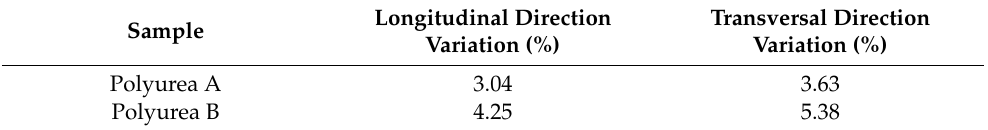
Table 2. Dimensional stability test results.